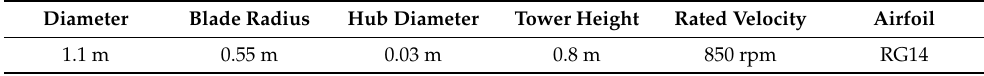
Table 1. Parameters of the wind turbine G1.